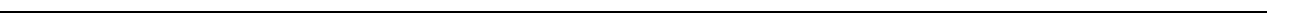
Fig. 1 A genome-wide CRISPR screen for PARP inhibitor resistance identi fi es in-frame Parp1 mutants. a Experimental scheme. b Locations of Parp1 guide RNA target sites in exon two of the mouse Parp1 gene. c Parp1 western blot of lysates from talazoparib-resistant clones identi fi ed in the CRISPR screen. Individual clones are colour-coded according to sgRNA present (see key). Clones 1, 2, 6, 7, 9, 12 and 13 with Parp1 sgRNAs have lost Parp1